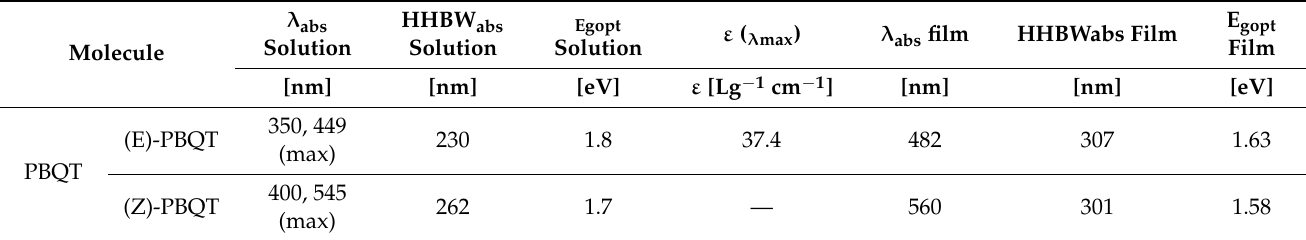
Table 2. Absorption optical properties in solution and film of the polymer PBQT